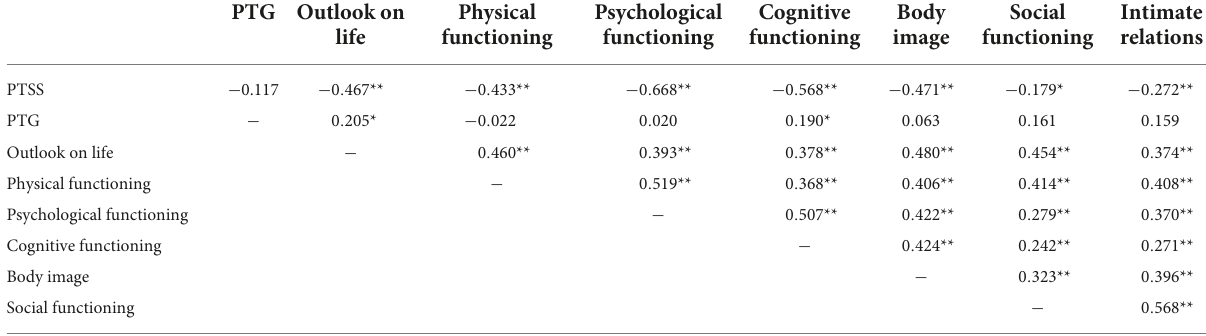
TABLE 3 Correlation analyses for the adolescent group ( N = 125).